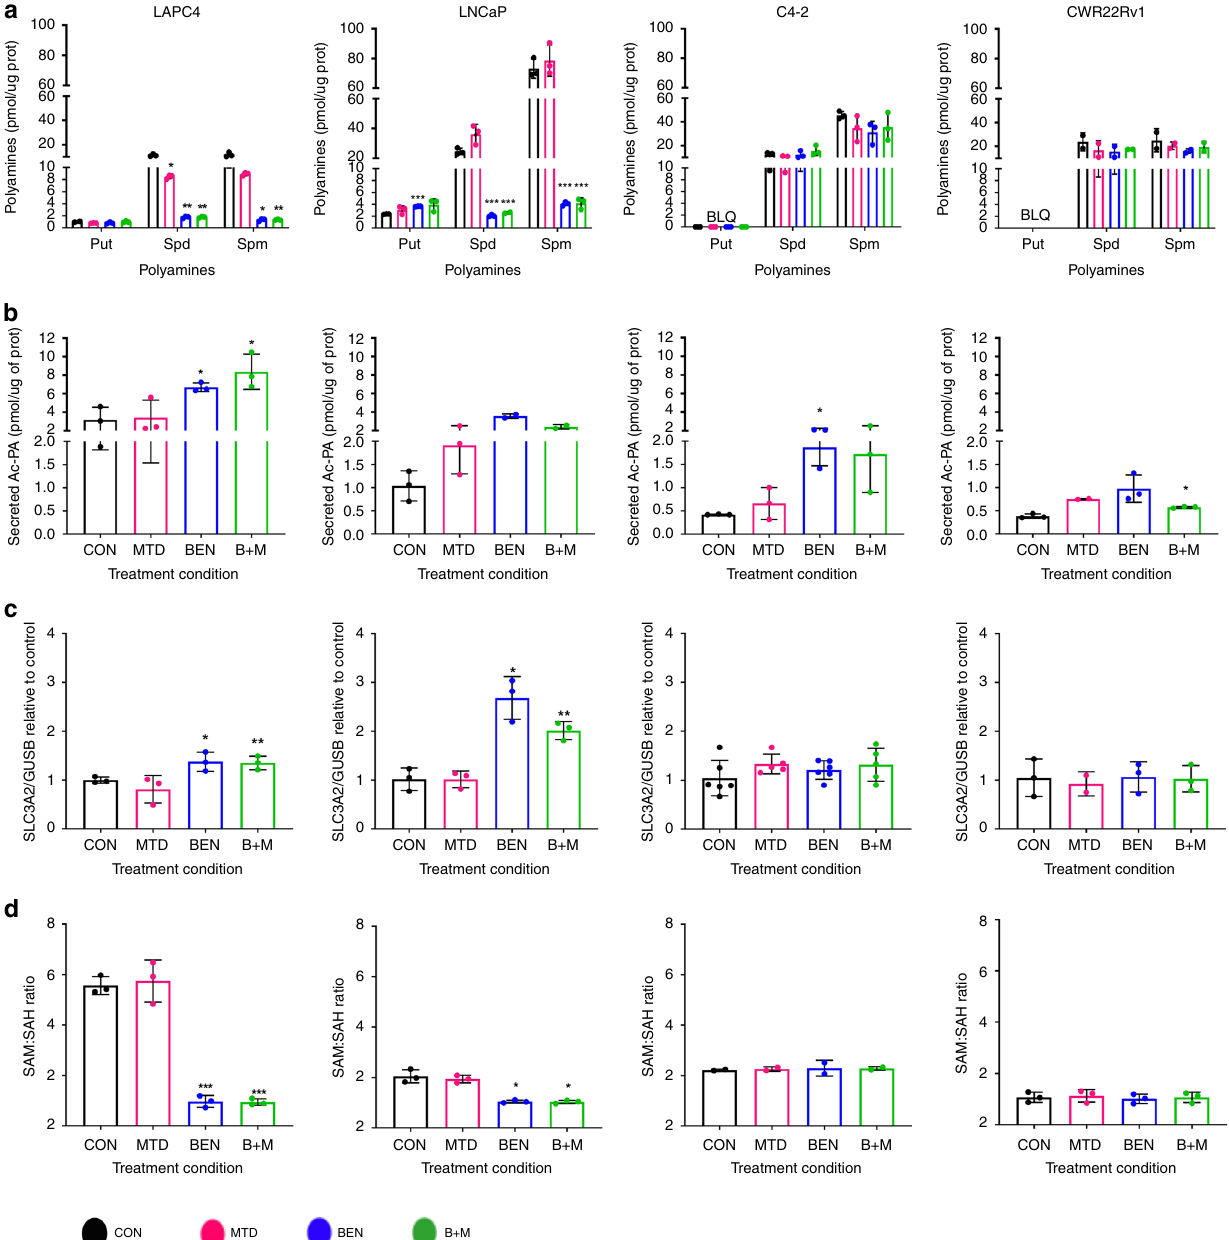
Fig. 3 Impacts on Polyamine Biosynthesis in androgen sensitive and androgen independent lines. LAPC-4, LNCaP, C4-2, and CWR22Rv1 cells were treated with vehicle control (black bars), 1 nM MTDIA (red bars), 1 µ M BENSpm (blue bars), or the combination (B + M) (green bars) for 8 days in the presence of 20 µ M MTA. a Intracellular putrescine, spermidine, and spermine levels measured by UPLC for all 4 cell lines. Values are normalized to protein concentrations. b Extracellular acetylated polyamines (acetylated spermidine + acetylated spermine) extracted from the media measured by UPLC. Values are normalized to intracellular protein concentrations. c RNA expression as measured by Real-Time rt-PCR for solute carrier 3 family member 2 ( SLC3A2 ). Values are normalized to GUSB expression and made relative to vehicle control. d Intracellular s-adenosylmethionine (SAM) to s-adenosylhomocysteine (SAH) ratio as measured by UPLC. Results for biological triplicates are shown. Statistical analyses were performed using an unpaired student t-test with Welch ’ s correction. All values are compared to vehicle control. Error bars represent the standard deviation of the mean. * p < 0.05, ** p < 0.01, *** p <